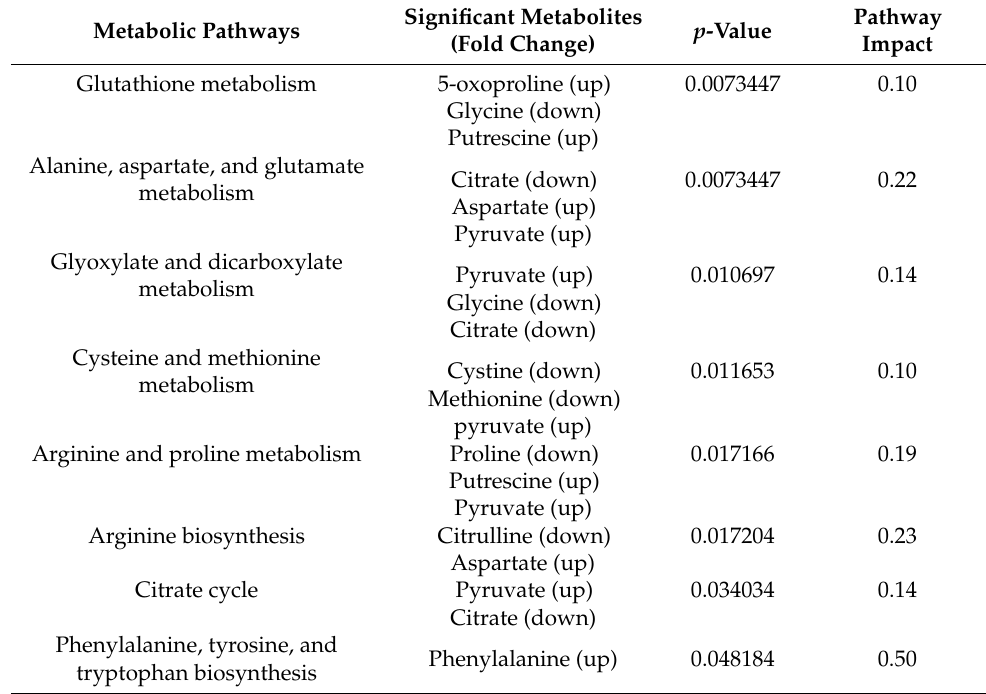
Table 4. Identified metabolites correlated to the significantly altered metabolic pathways in dogs infected with B. canis